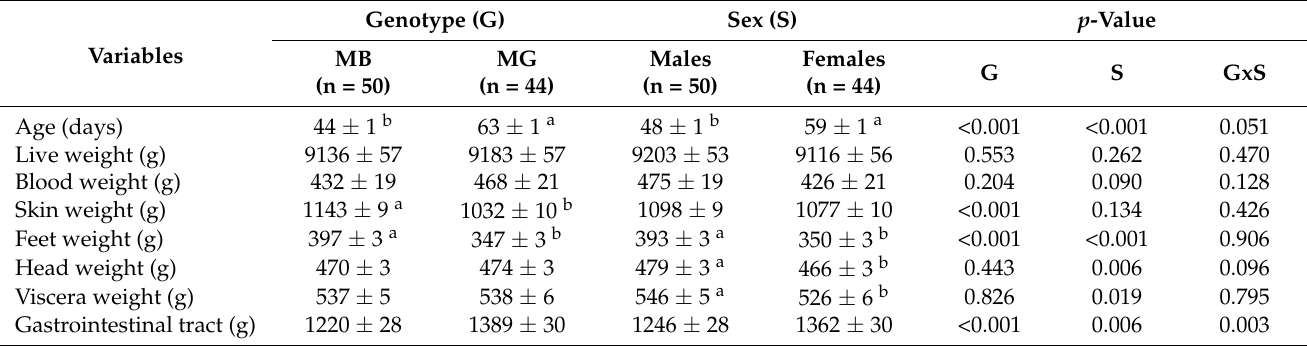
Table 1. Least-square means ( ± SE) for age, slaughter weight and non-carcass weight components from kids according to genotype (purebred Murciano-Granadina (MG) or crossed with Boer (MB)) and